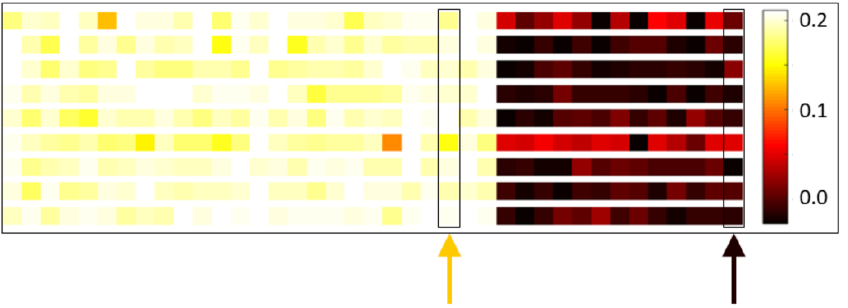
Figure 9. First principal component loadings. Visualization of the average first principal component loadings for nine randomly selected subjects (one subject per row). Each row consists of 39 colored panels, one for each of the 39 electrode – RMS feature combinations used for classification. The panels are colored in proportion to the contribution of their corresponding feature to the first principal component; they are ordered in three blocks of 13 corresponding to the 13 analyzed electrodes, with the leftmost block representing the theta RMS feature, the middle block representing the alpha RMS feature, and the rightmost block representing the beta RMS feature. Within each block, the electrode ordering is as follows: F7, F3, Fc5, T7, P7, O1, O2, P8, T8, Fc6, F4, F8, and Af4. For example, the leftmost panel in all rows represents θ RMS on electrode F7 and the rightmost panel β RMS on Af4. Lighter color panels indicate electrode – RMS feature combinations with stronger positive weightings. The orange arrow indicates one particular combination that has relatively high-magnitude weight across subjects; the black arrow indicates one with relatively low-magnitude weight.